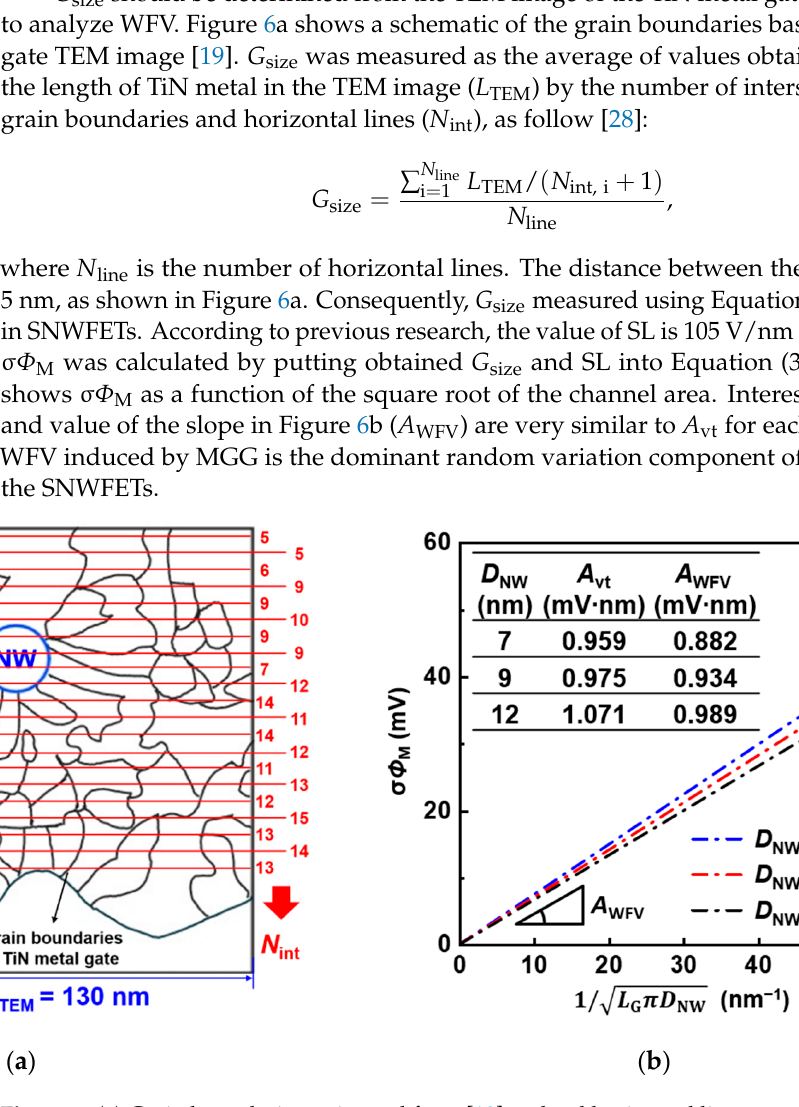
Figure 6. ( a ) Grain boundaries estimated from [19] and red horizontal lines to estimate G size of TiN metal gate of SNWFETs. ( b ) Pelgrom’s plot only considering work function variation (WFV) by metal gate granularity (MGG).